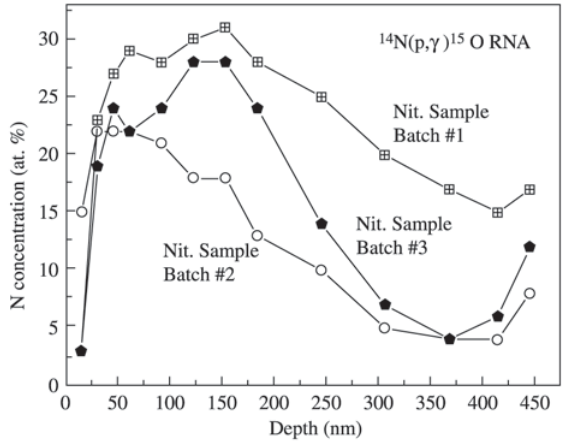
Figure 8. Near-surface nitrogen concentration as a function of the depth for nitrided sample. The solid line is a guide to the